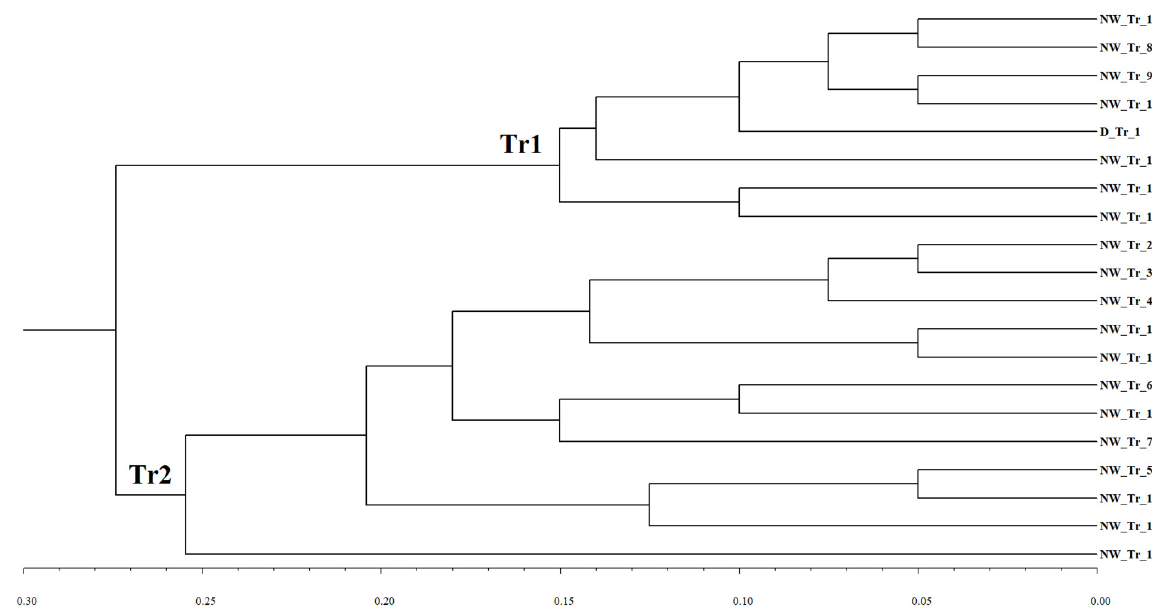
Figure 2. UPGMA dendrogram of relationships among P. striiformis pathotypes from triticale based on the simple mismatch dissimilarity between them. Abbreviations of regions and host species: D—Dagestan; NW—North-West; Tr—triticale. For example, pathotype designation NW_Tr_1 means that this pathotype is number 1 from triticale in the North-West region. Two clusters of the triticale pathotypes Tr1 and Tr2 are shown.